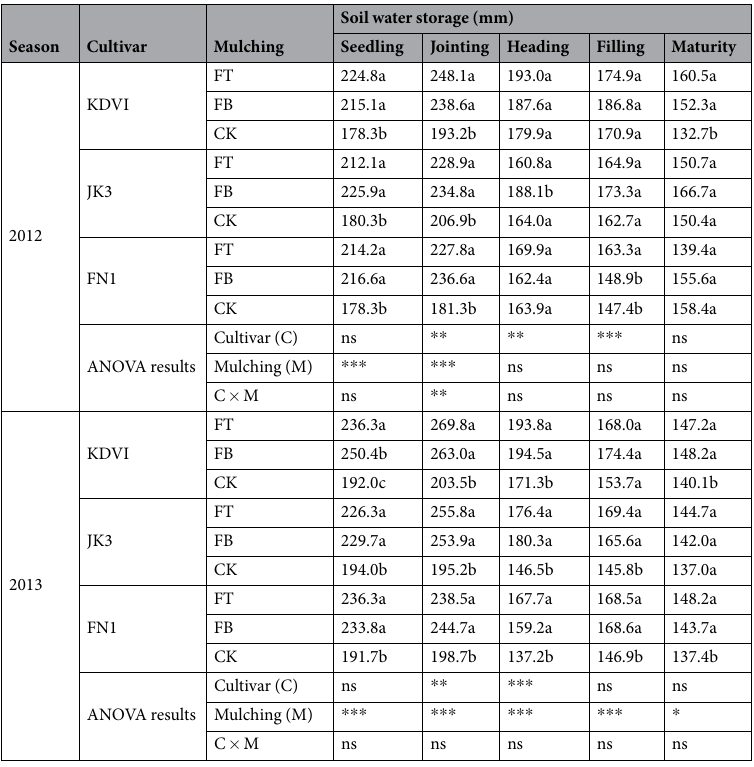
The changes in mean soil tem- perature at three key developmental stages (sowing to heading, heading to filling and filling to maturity) were presented in Fig. 2. In comparison with FB and CK, FT significantly increased topsoil temperature in all cultivars across two growing seasons. Furthermore, FB shared similar time-course dynamics in soil temperature as CK did in 2012 growing season. When it came to 2013 growing season, however, FB significantly ( p < 0.05) reduced soil temperature by 1.1 °C from sowing to heading, 0.64 °C from heading to filling and 0.45 °C from filling to maturity, respectively, as compared with CK. The differences in soil temperature among the cultivars were not significant over two growing seasons. FB treatment recorded greater soil temperature reduction in the early-maturing KDVI (1.03 °C) plots than that of mid-maturing JK3 (0.45 °C) and late-maturing FN1 plots ( − 0.44 °C).